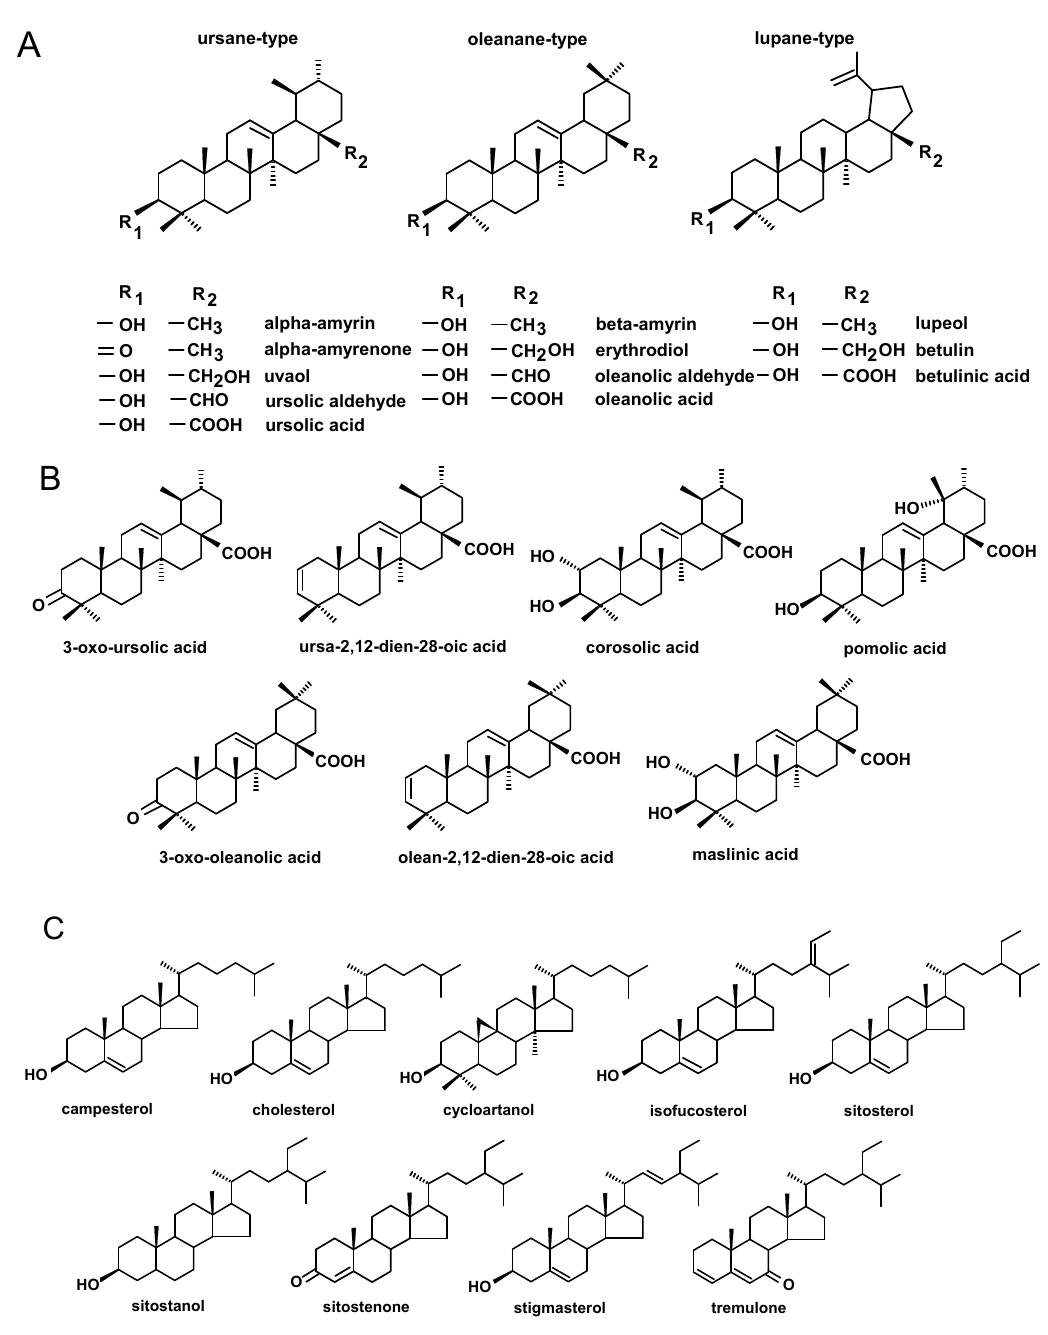
Figure 1. The structures of alcohols, ketones, aldehydes and acids of oleanane-, ursane- and lupane-type skeletons ( A ), derivatives of oleanolic and ursolic acids ( B ) and steroids ( C ) identified in cuticular waxes of fruit analyzed in this study.